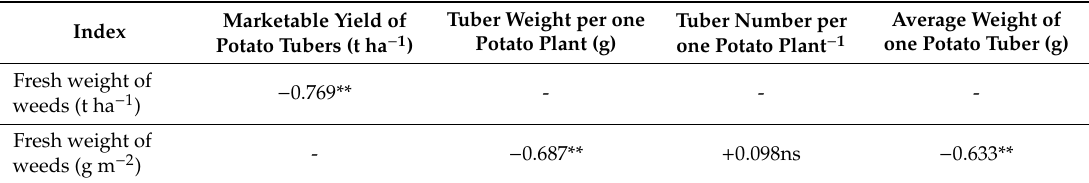
Table 7. Significant values of linear correlation coe ffi cients between the fresh weight of weeds and the marketable yield of potato tubers and components of potato yield (means for cultivars and 3 study years).